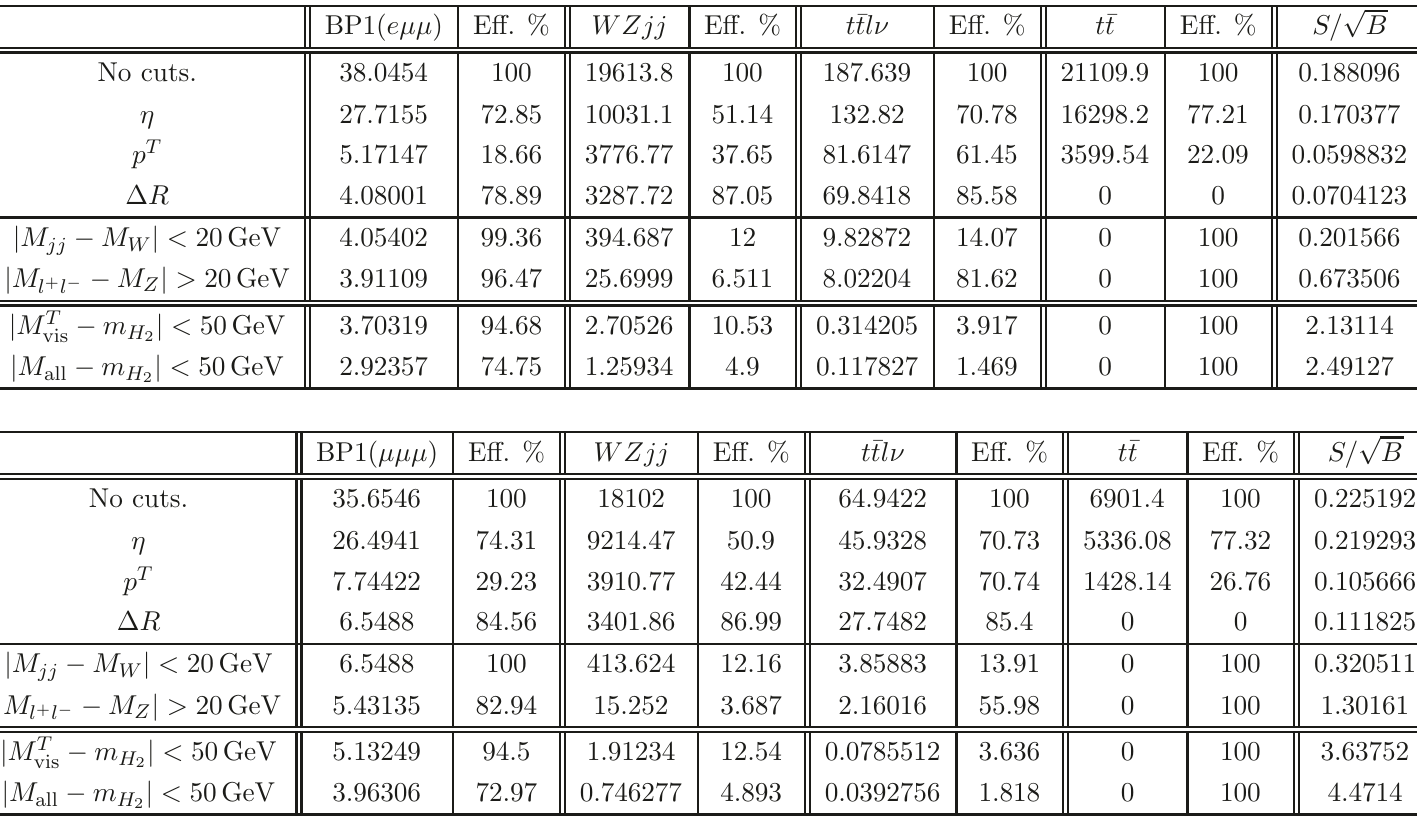
= 100fb − 1 . Universal acceptance cuts = L > 7 µ 3